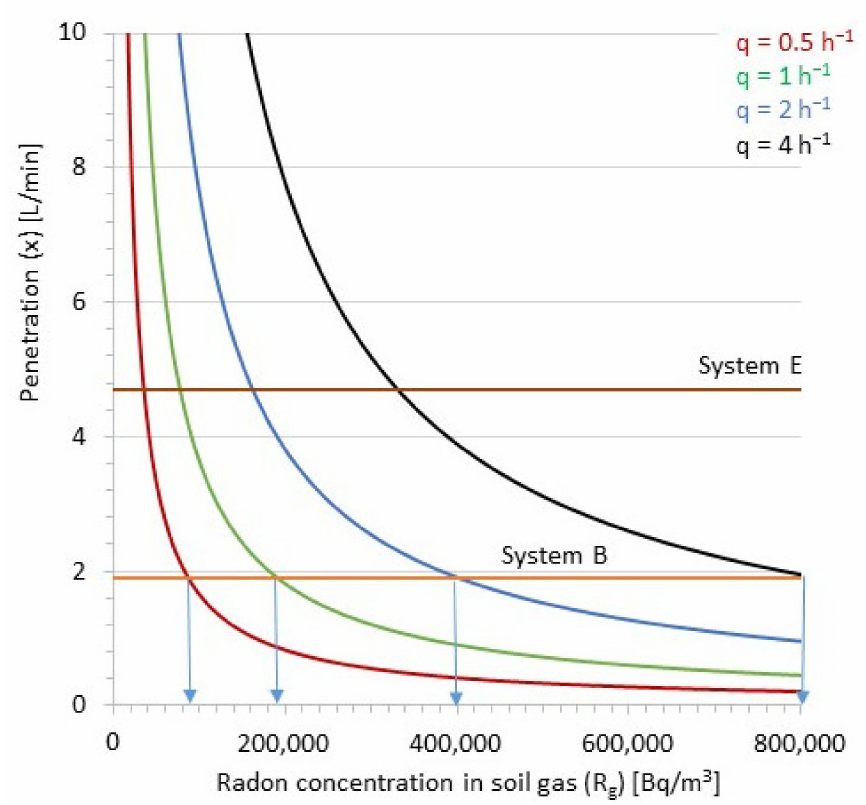
Figure 10. Radon barriers for System B and E, where the intersection between the horizontal line measuring the airtightness and the curves for the air-change rates provides the radon concentration in soil gas.